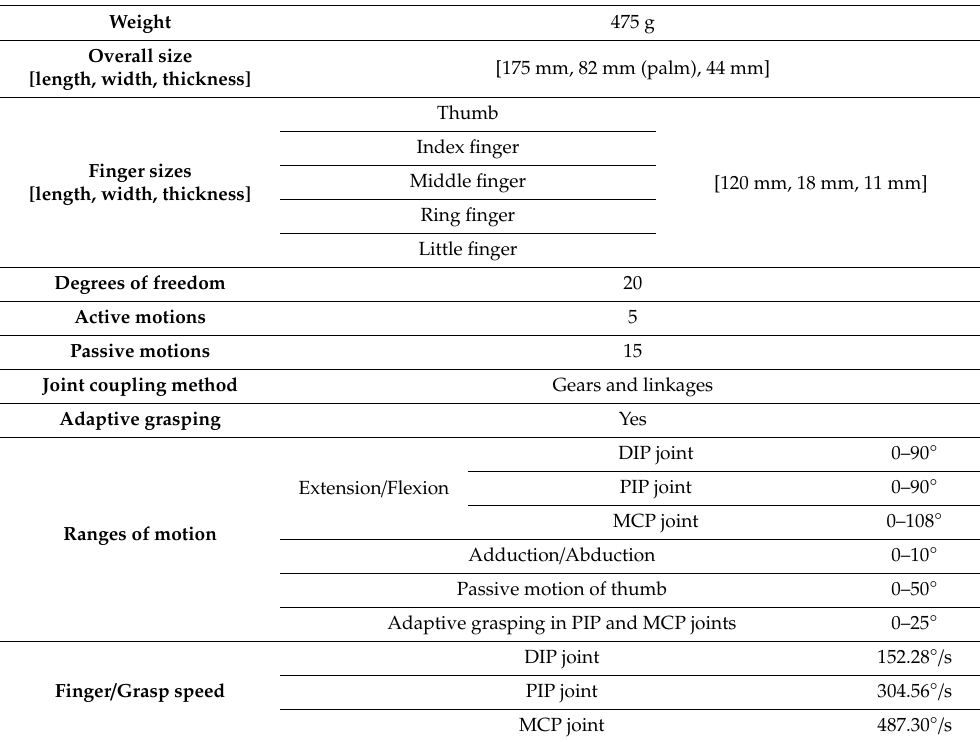
Table 2. Specifications of the developed prosthetic hand. 241